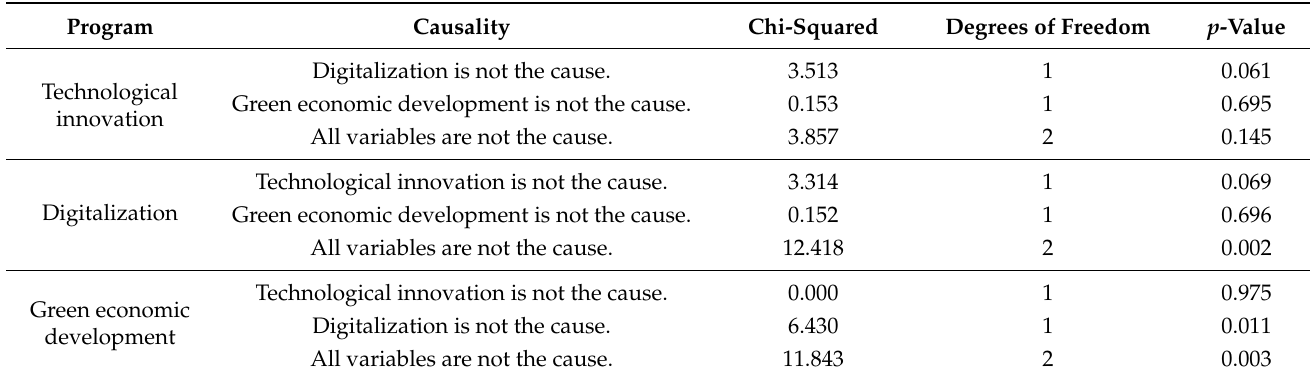
Table 7. Granger causality test